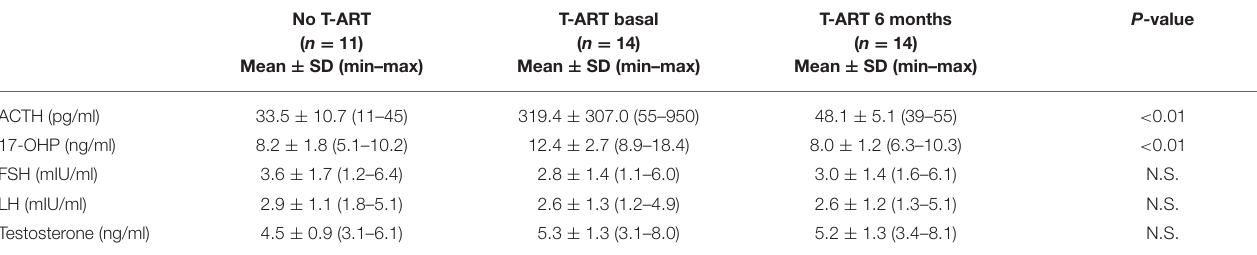
TABLE 1 | Hormonal profile in patients without testicular adrenal rest tumor and with testicular adrenal rest tumor at basal condition and after 6 months of modified glucocorticoid treatment.